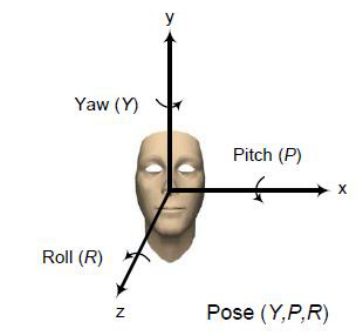
Figure 7. Face system of coordinates